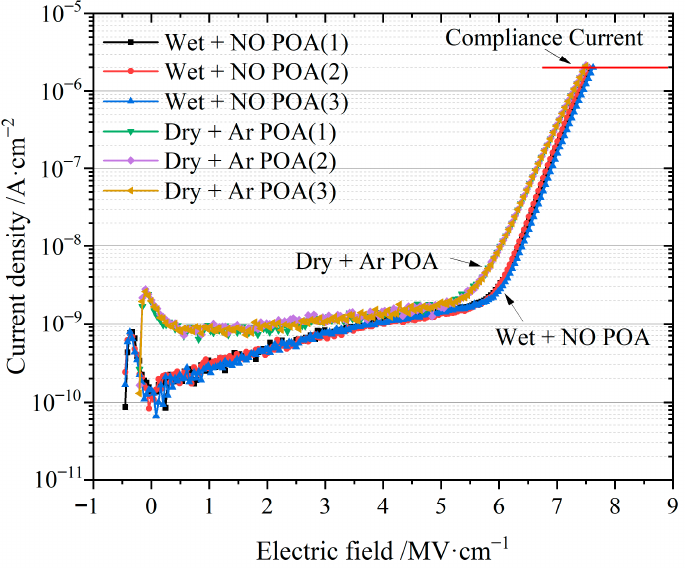
Figure 4. First measured current density-electric field characteristics for both the samples.